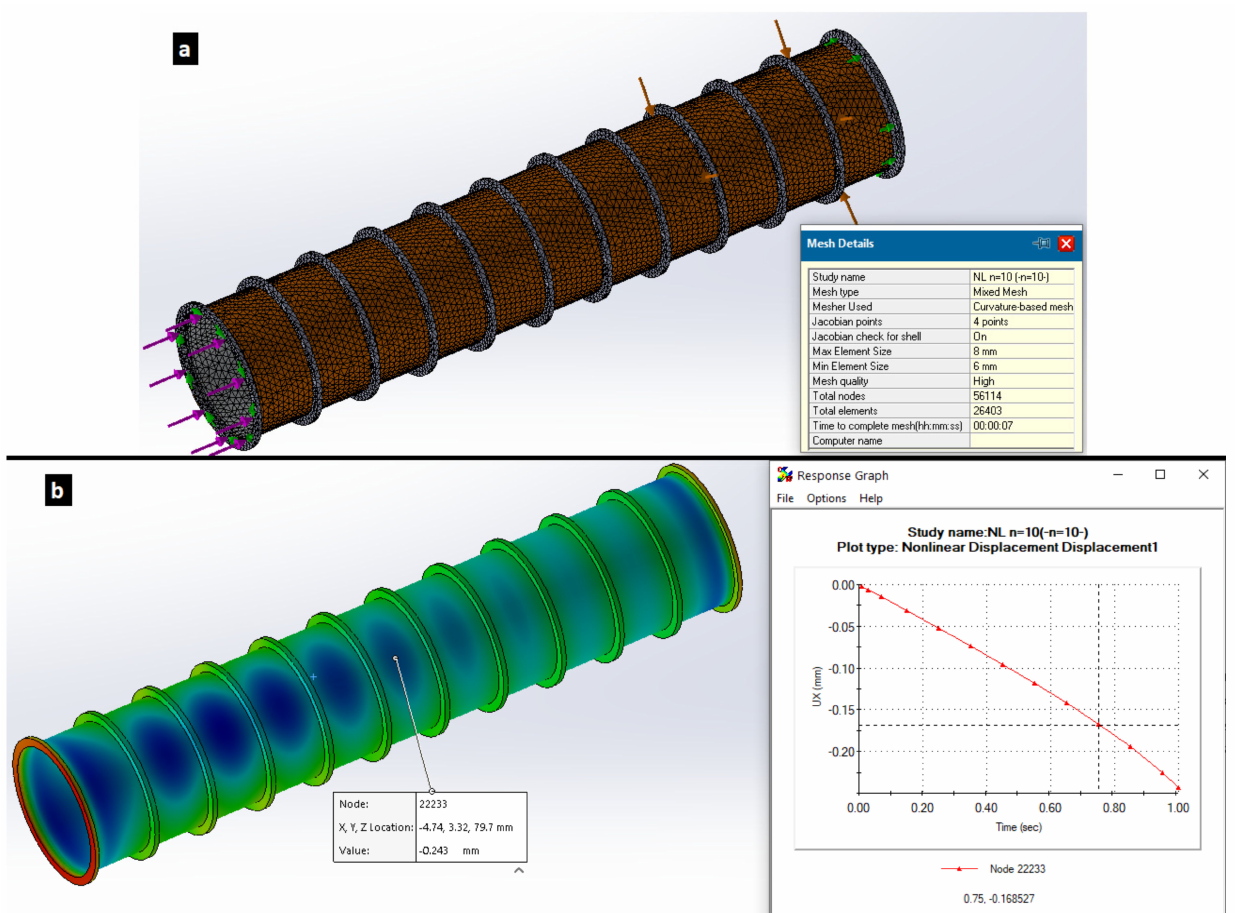
Figure 10. Stiffened cylinder–Nonlinear buckling: ( a ) mesh and parameters; ( b )